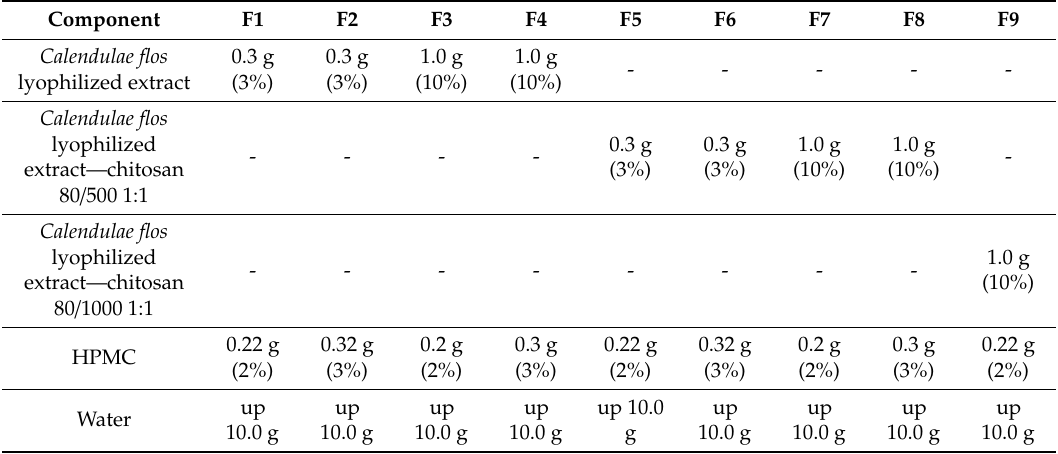
Table 1. Composition of HPMC-based hydrogel with chitosan delivery system with Calendulae flos lyophilized